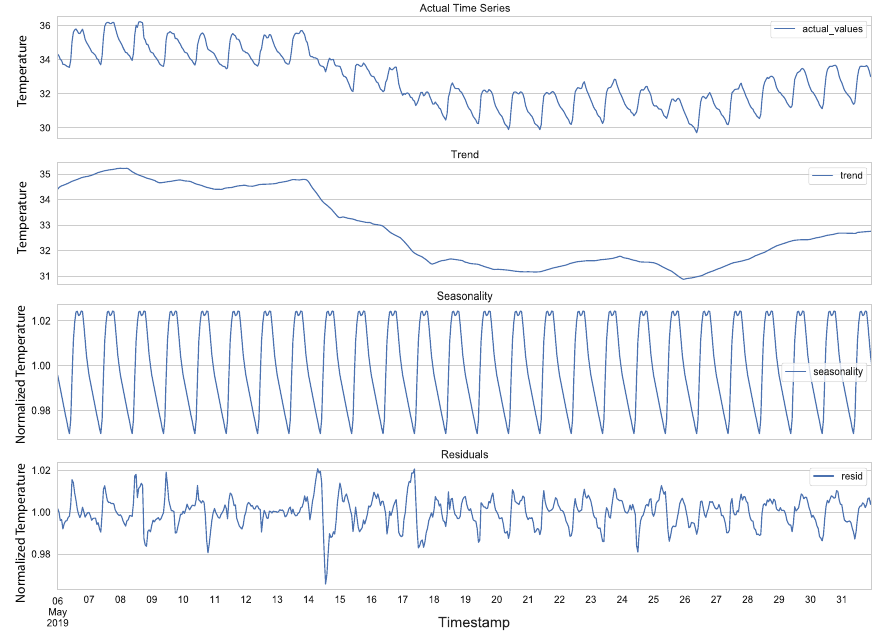
Figure 2. Time Series Decomposition in Trend, Seasonality, and